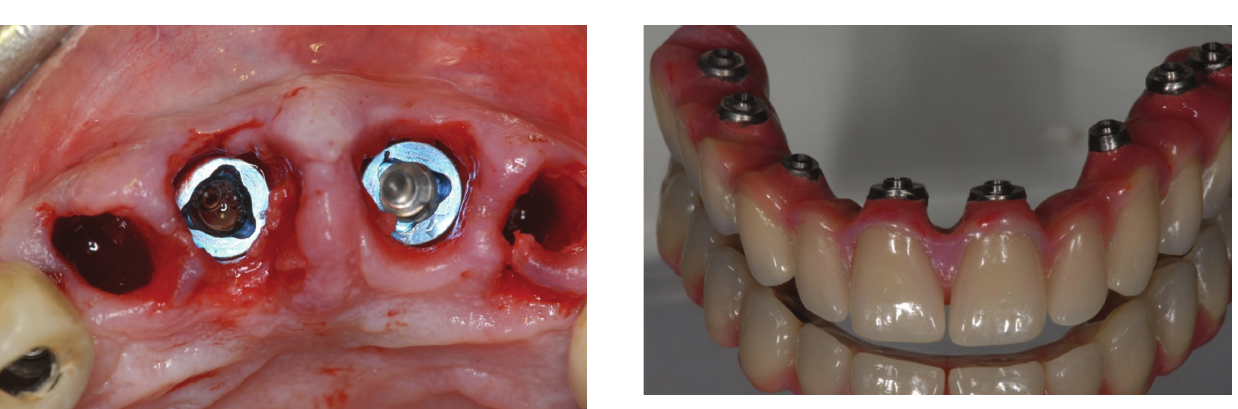
Figure 15: Toronto dental